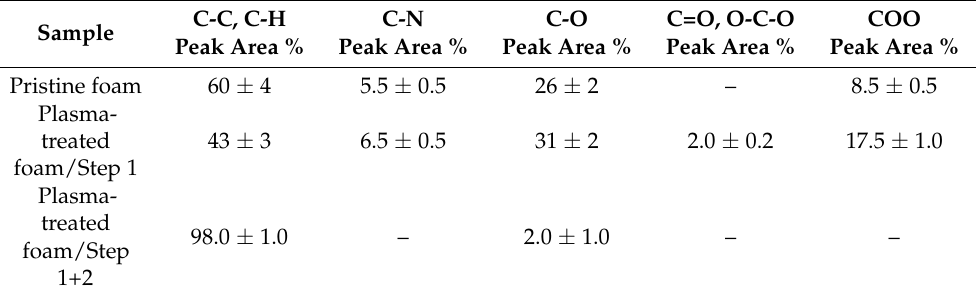
Table 2. Curve fitting results of C 1s XPS spectra of the pristine PU foam, the foam after step 1 (t e/n = 10 min), and the foam after the two-step plasma process (t e/n = 10 min, t d = 10 min).